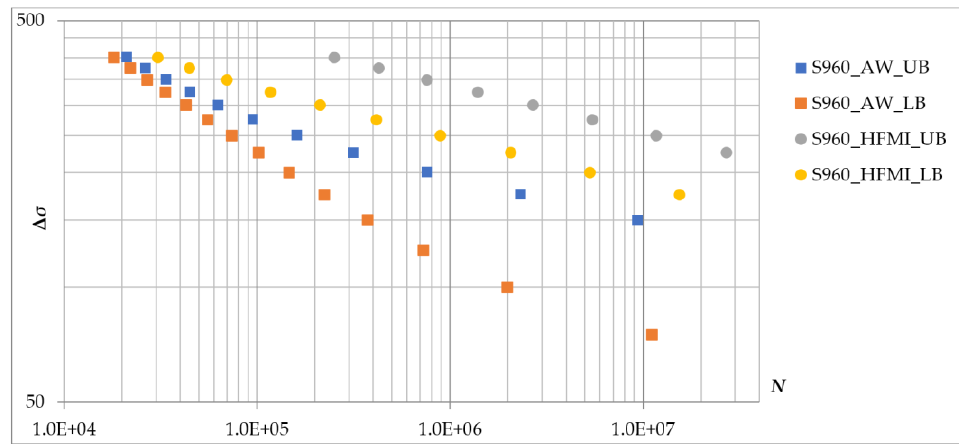
Figure 13. Results of calculated fatigue life for S960 (AW and HFMI condition).